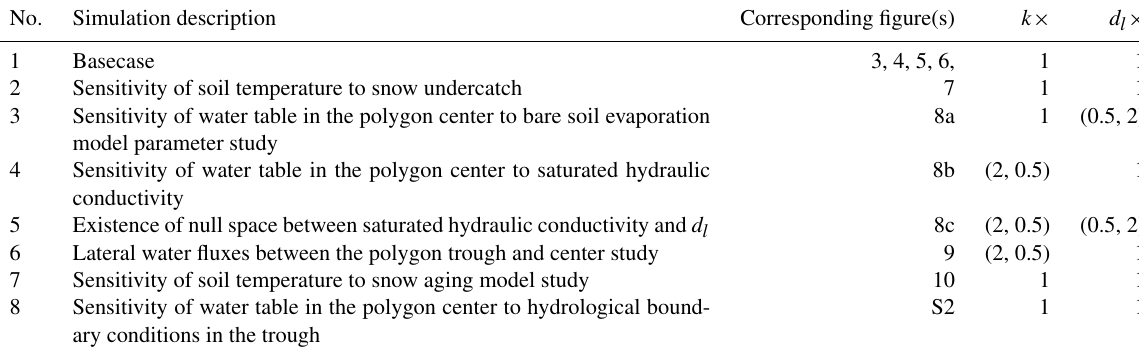
Table 1. Overview of simulations conducted in the study. The parameters used in the basecase are provided in Table 2. The parameter k is the intrinsic permeability, and d l is bare soil evaporation model parameter. The × denotes multiplication of the basecase value by the value in the column. The values in parenthesis correspond to different simulations for sensitivity studies.